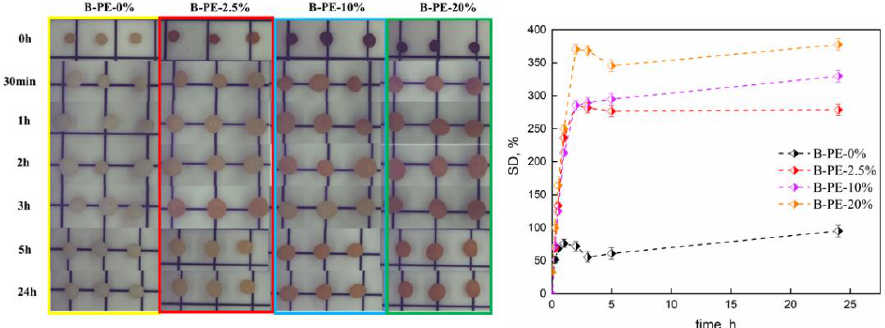
Figure 6. Pictures of swelled B-PE ( left ) and swelling degrees (%) of beads as a function of time at